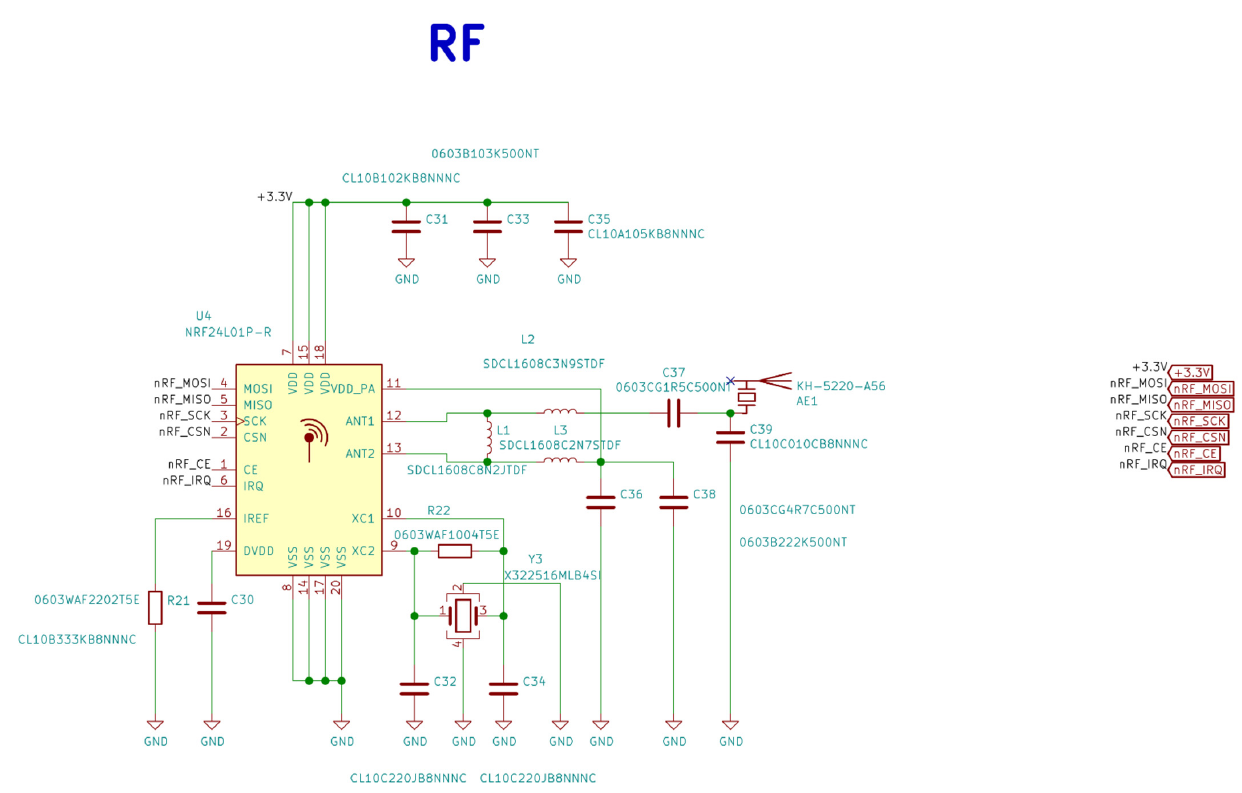
Figure A4. Electrical schematic diagrams of radio frequency system-on-chip in the base station.